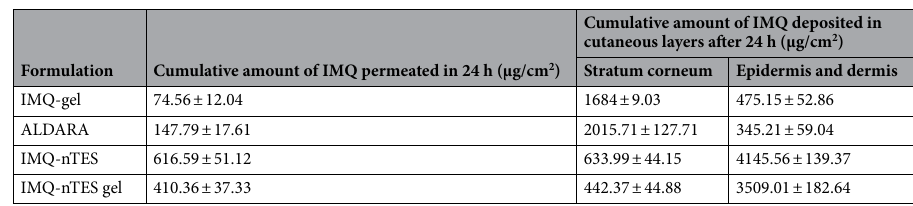
Table 5. Cumulative amount of IMQ deposited and permeated through the skin. All values are mentioned as a Mean ± S.D (n = 3).